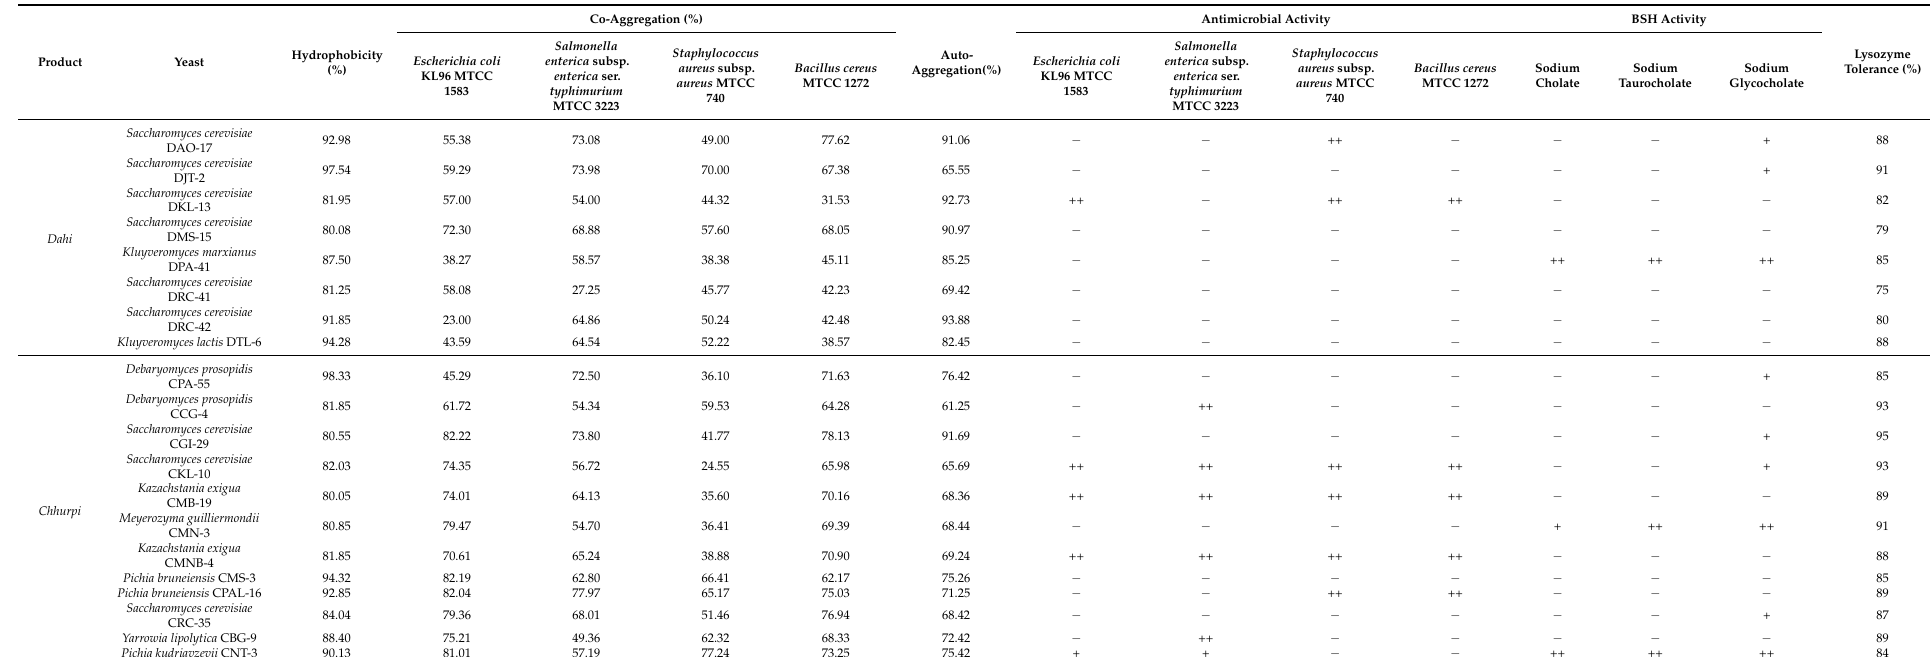
Table 5. Probiotic characteristics of yeasts isolated from dahi and chhurpi of